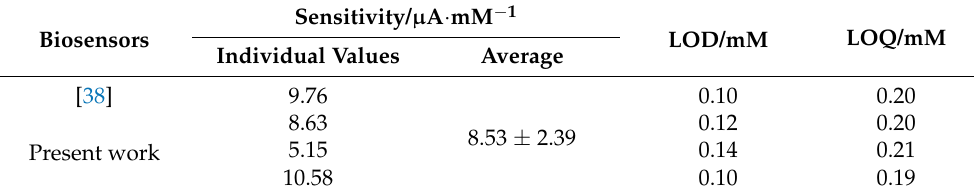
Table 1. Values of sensitivity, LOD, and LOQ obtained for several Ti/TiO 2 NTAs/ppHEMA- co-EGDA/pgPFM/GOx/Chitosan biosensors. The linear range was equal for all of the evalu- ated